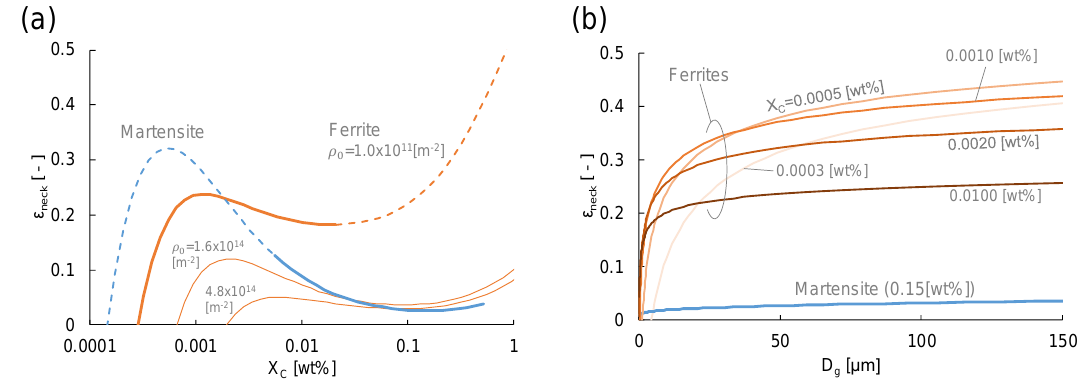
Figure 17. (cid:101) neck against ( a ) X C and ( b ) D g in ferrite and